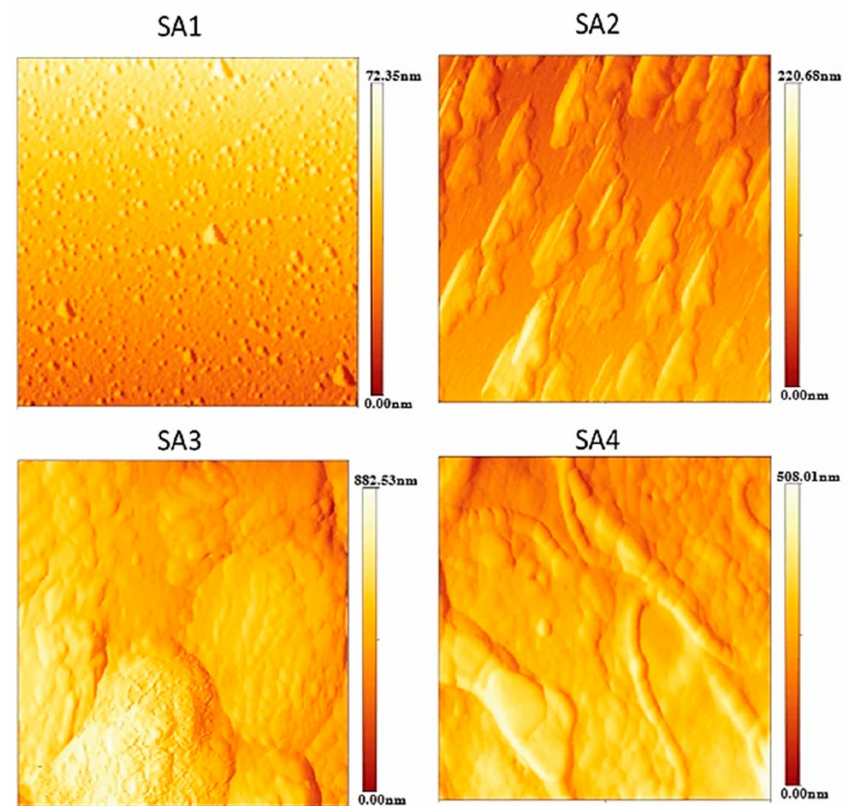
Figure 9. The AFM micrographs of SA1, SA2, SA3 , and SA4 were gained in the close contact mode (3 × 3 mm). Reprinted with permission from [60]. Copyright RSC Publishers,